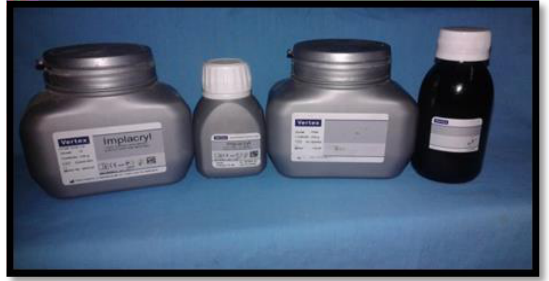
Figure 1 : Heat Cure acrylic material and soft liner